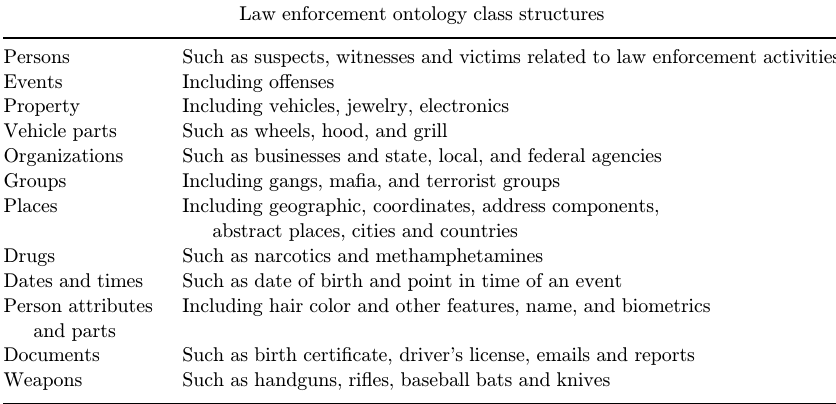
Table 1. High-level class structure for law enforcement ontology. Law enforcement ontology class